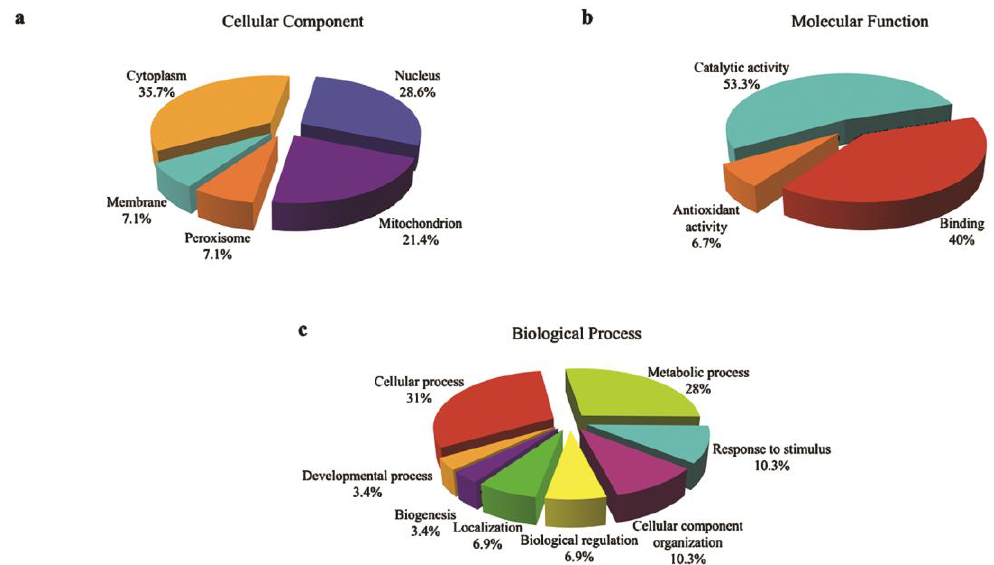
Figure 4. Gene ontology (GO) categories of identified proteins expressed by Metarhizium anisopliae infecting Coptotermes